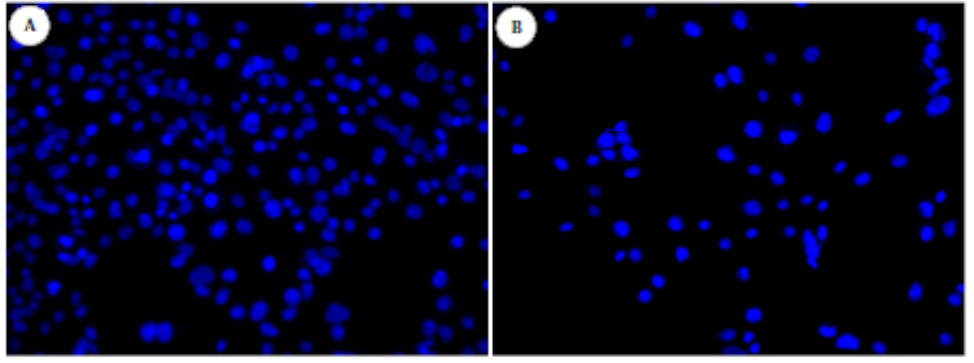
Figure 6. Effect of silver(I) compound coated-surfaces on fibroblast cells. DAPI staining was assessed at day 3. Cells were fixed onto surfaces, permeabilized, stained with DAPI and examined using a fluorescent microscope. ( A ): gold Au(111) uncoated; ( B ) gold Au(111) coated with silver(I) compound 2 .